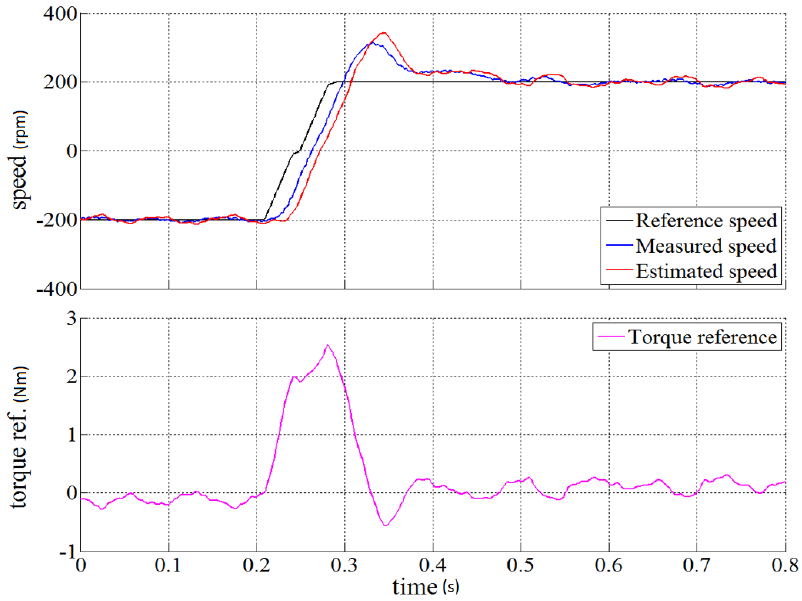
Figure 12. Motor #1: Sensorless speed control (MTPA), – 200 to +200 rpm inversion, typical (no-adaptation) rotating voltage injection, no load.